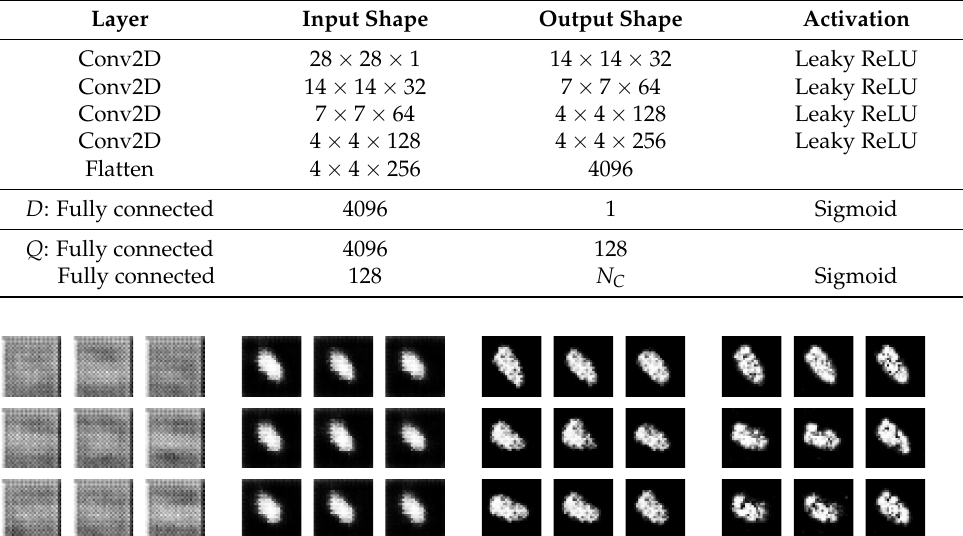
Figure 5. Some images generated by InfoGAN with different numbers of iterations in the training process: 50 iterations ( first ); 500 iterations ( second ); 5000 iterations ( third ); 10,000 iterations ( fourth